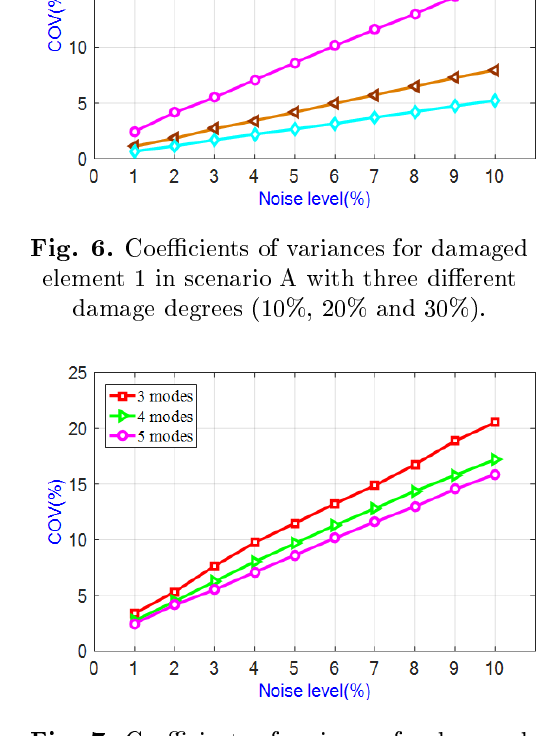
Fig. 7. Coe(cid:30)cients of variances for damaged element 1 in scenario A, using di(cid:27)erent vibration modes ((cid:28)rst 3, 4 and 5 modes